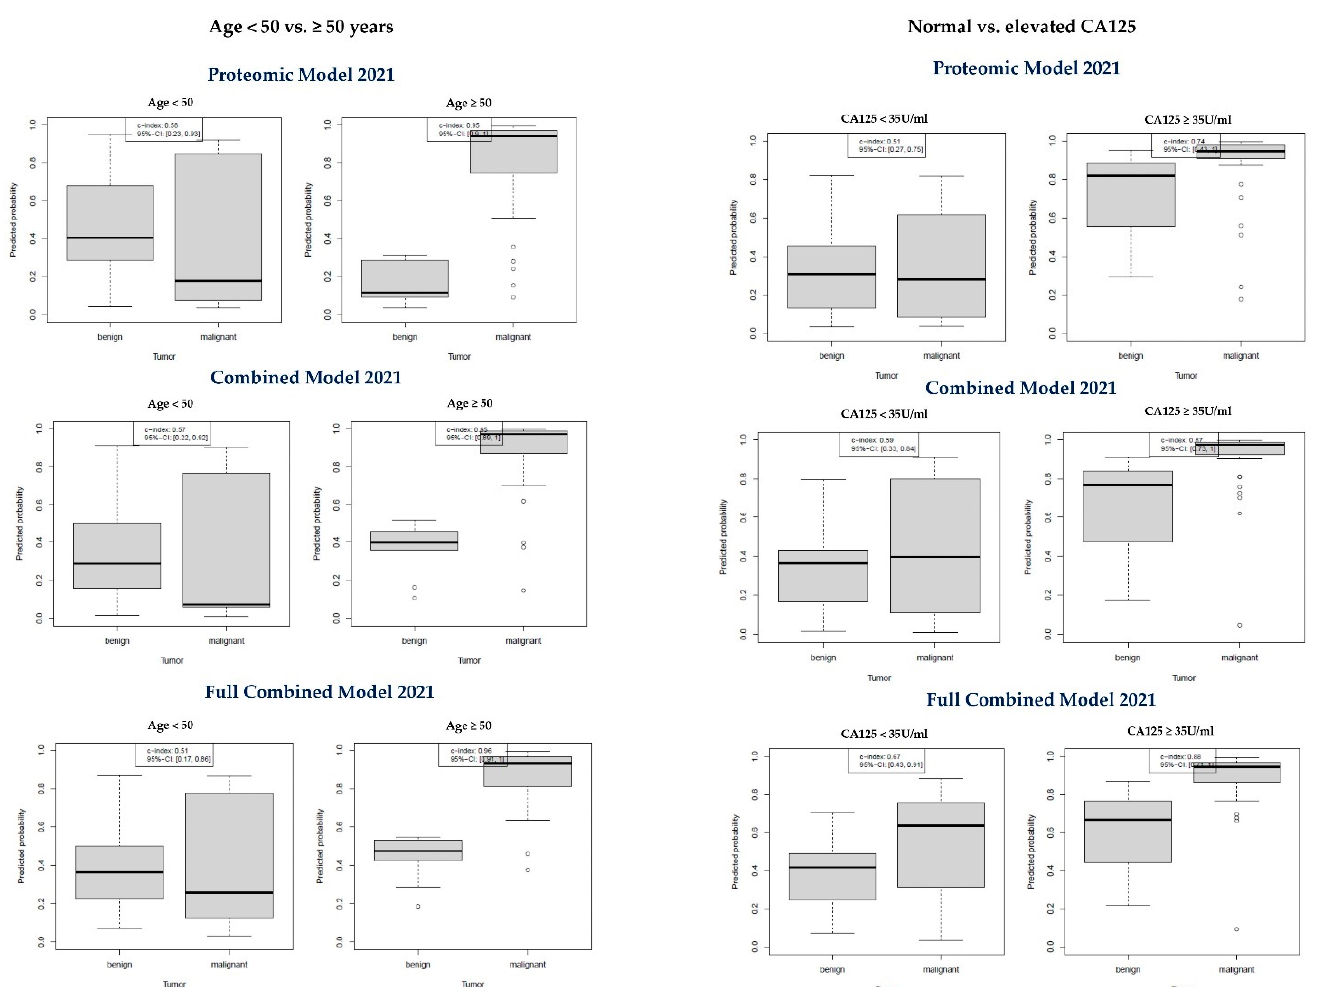
Figure 3. Diagnostic performance of the new models by age (cutoff: 50 years) and CA125 level (cutoff 35 U/mL). Table 4. Diagnostic performance broken down by CA125 (cutoff 35